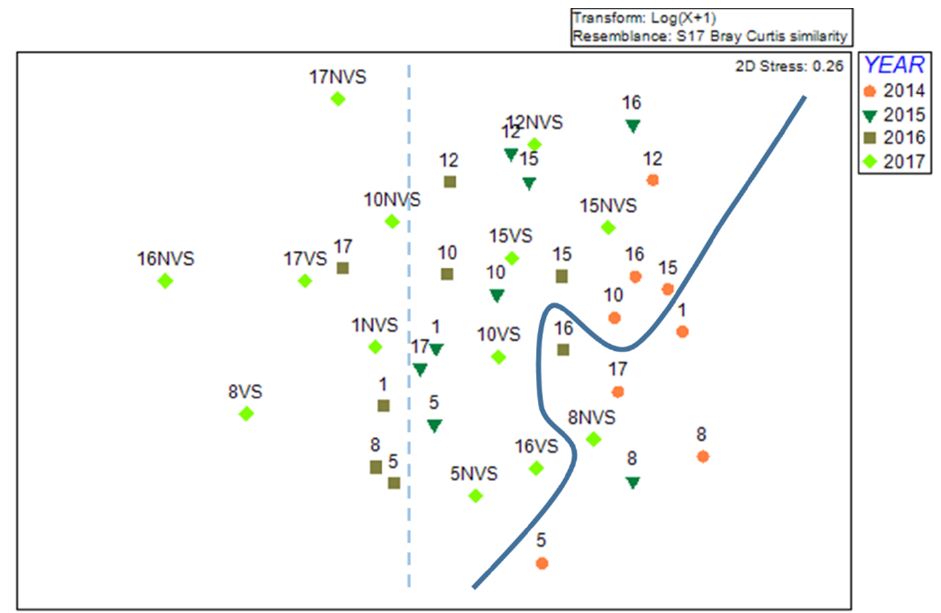
Figure 5. MDS plot applied to the abundance data of the eight samples grouped by year.